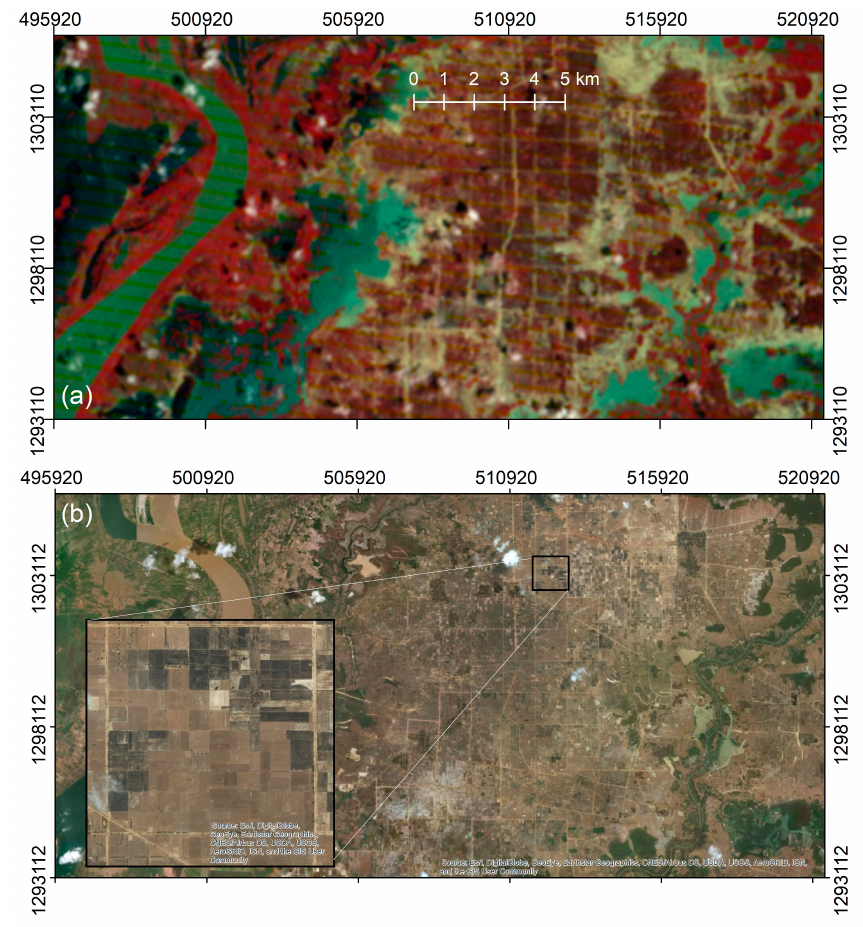
Figure 1. ( a ) 1979 satellite image at the borders of Kampong Chang and Kandal provinces, Cambodia; ( b ) current satellite imagery from Esri. Both show the Khmer Rouge grid irrigation network. The inset in Figure 1b shows smaller canals spaced 100 m apart within the 1 km